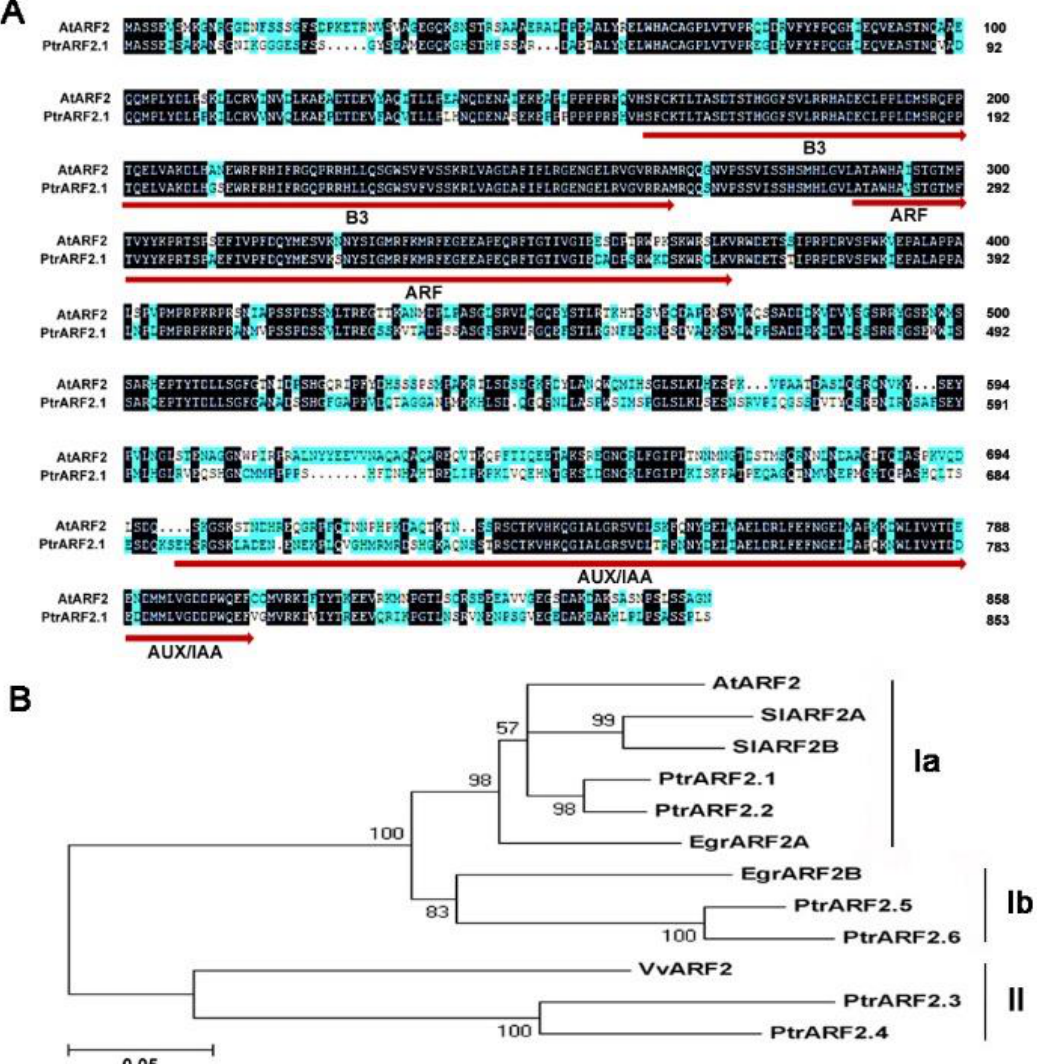
Figure 1. Amino acid sequence from Populus trichocarpa with other species. ( A ) Sequence alignment of PtrARF2.1 in P. trichocarpa with AtARF2 in Arabidopsis thaliana . Peptide sequences were aligned by DNAMAN software. Identical and similar amino acid residues are indicated by dark and blue background, respectively. Numbers on the right refer to amino acid sequence positions. These conserved DBD/B3, ARF and Aux/IAA domains in ARF2 protein are underlined. ( B ) Phylogenetic analysis of the poplar and selected ARF2 proteins was performed by the neighbour-joining method using MEGA version 5. Bootstrap support is indicated at each node. Bar, 0.05 substitutions per site. Additional sequences include A. thaliana (AtARF2), Solanum lycopersicum (SlARF2A and SlARF2B), Vitis vinifera (VvARF2), Eucalyptus grandis (EgrARF2A and EgrARF2B). The accession numbers of ARF factor sequences are given in the Materials and Methods